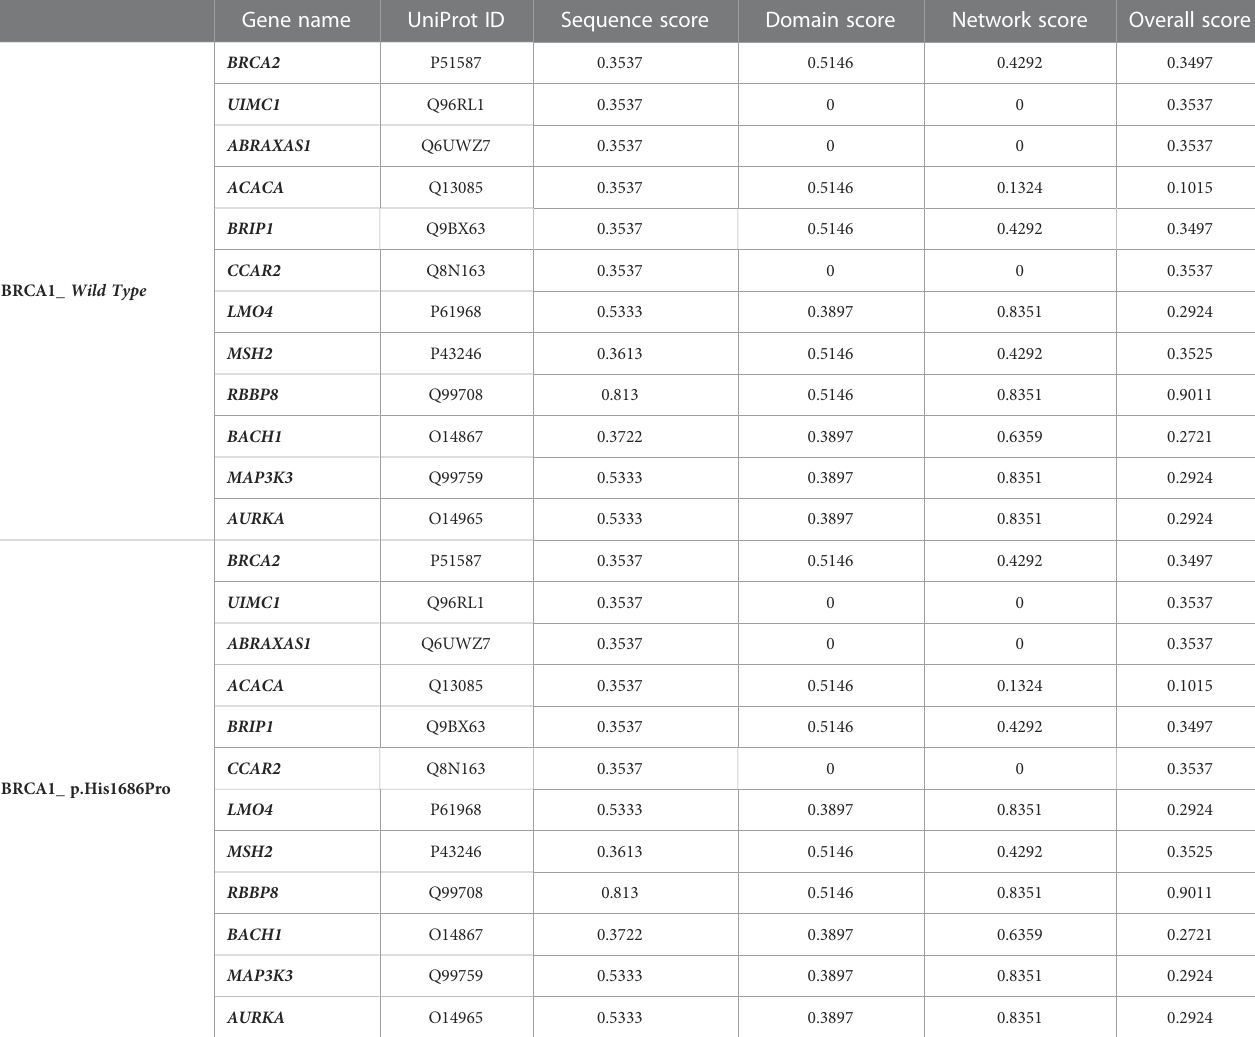
TABLE 1 Protein – protein interaction (PPI) prediction by